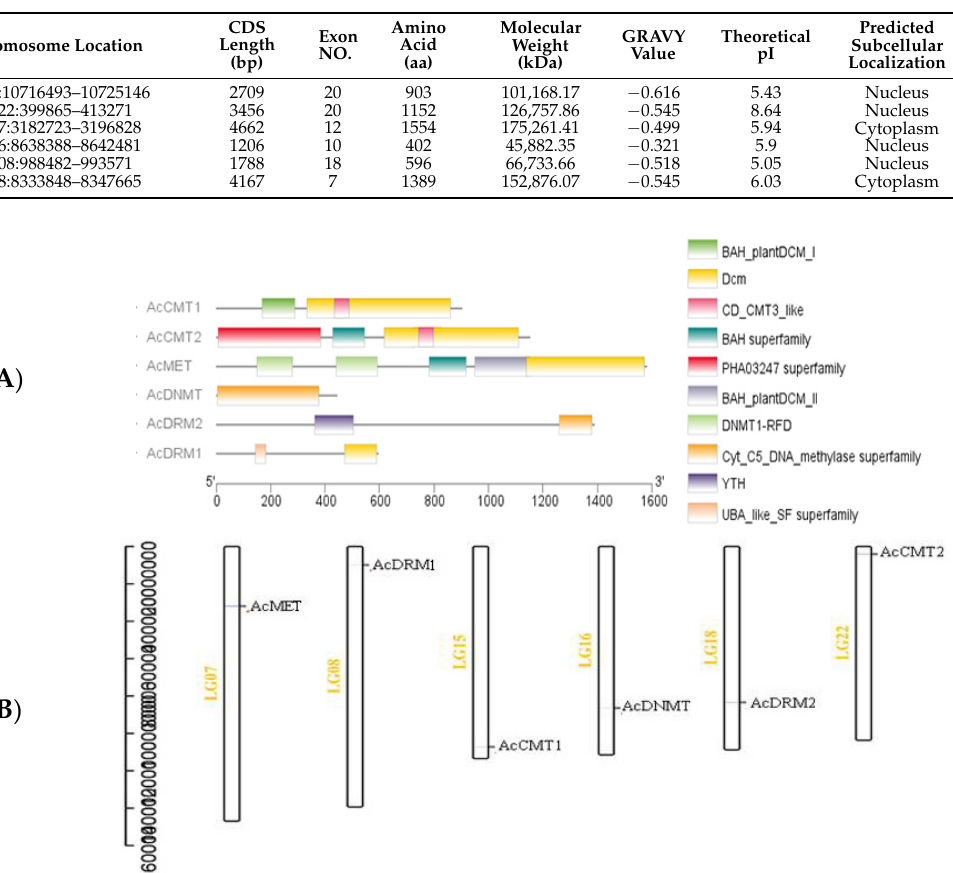
Figure 2. Conserved domain analysis of AcC5-MTase and chromosomal location. ( A ) Different domains are represented in different colors along with the conservative domain of prediction, as shown in the legend. BAH_plant DCM_I: Bromo-adjacent homology domain, Dcm: Site-specific DNA-cytosine methylase, CD_CMT3_like: chromodomain of chromomethylase 3, PHA03247 super family: large tegument protein UL36, DNMT1-RFD: Cytosine-specific DNA methyltransferase replication foci domain, Cyt_C5_DNA_methylase: Cytosine-C5-specific DNA methylases, YTH: YT52-B-like domain. ( B ) Location of AcC5-MTase genes on the chromosome.